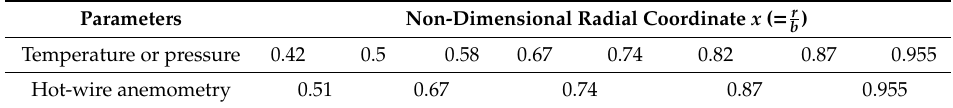
Table 2. Positions of the measurements in the test rig.